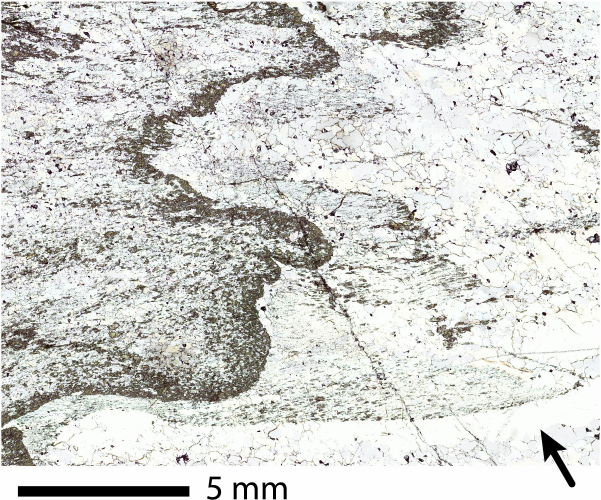
Figure A1. Transmitted-light scan of layers 2–3. Plane-polarized light.